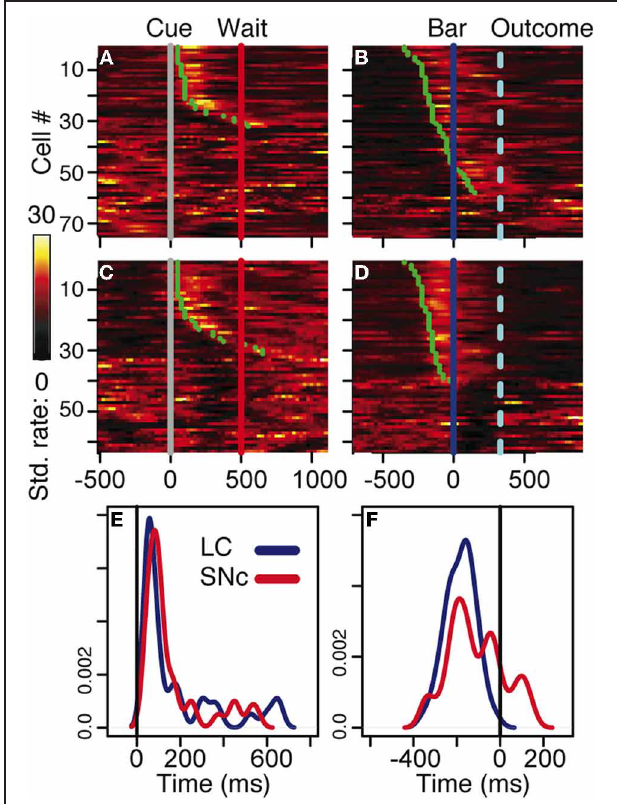
FIGURE 3 | Neuronal activity. (A–D) firing rate of the population of SNc (A–B) and LC (C–D) units at the cue (A,C) and the bar release (B,D) . In all four plots, each line is the color-coded standardized ( z -scored) firing rate of a single neuron around the event of interest. An additional line indicates the time of the wait signal relative to cue onset, and the average time of the outcome relative to the bar release. Neurons are sorted by increasing latency of the response (green dot). At the cue, about half of the neurons in SNc (A) and LC (C) display a transient activation at cue onset, with a similar timing between the two populations. A comparison of the distribution of SNc and LC response latencies at cue onset (E) confirms that the timing of the responses of these two populations was undistinguishable. At the bar release, both SNc (B) and LC (D) neurons display a transient activation right before the bar release. In the LC, the activation of all responding neurons started before the bar release whereas in the SNc, neurons started to respond both before and after the bar release. This was confirmed when we plotted the distribution of response latencies around bar release for these two populations (F) .